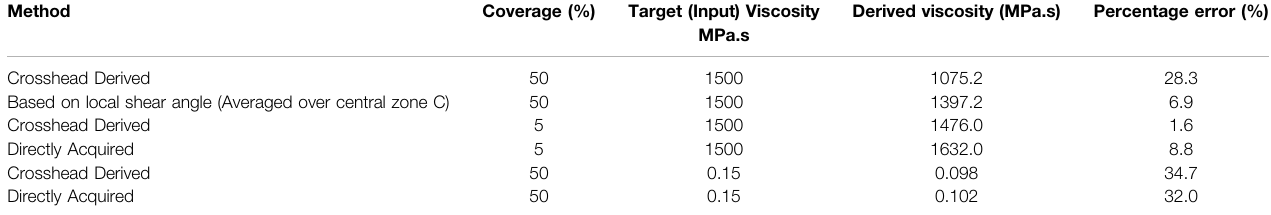
TABLE 2 | Calculated viscosity at both 50% coverage and 5% coverage fi rstly derived using Eq. 1 based on crosshead displacement and then secondly derived by averaging the pure shear zone C taking values directly from the model.